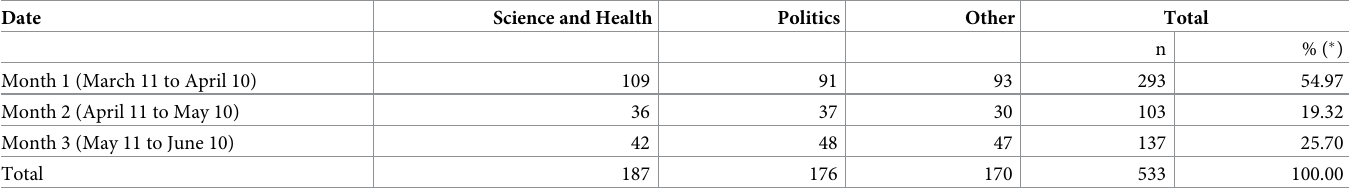
Table 4. General content of hoaxes by